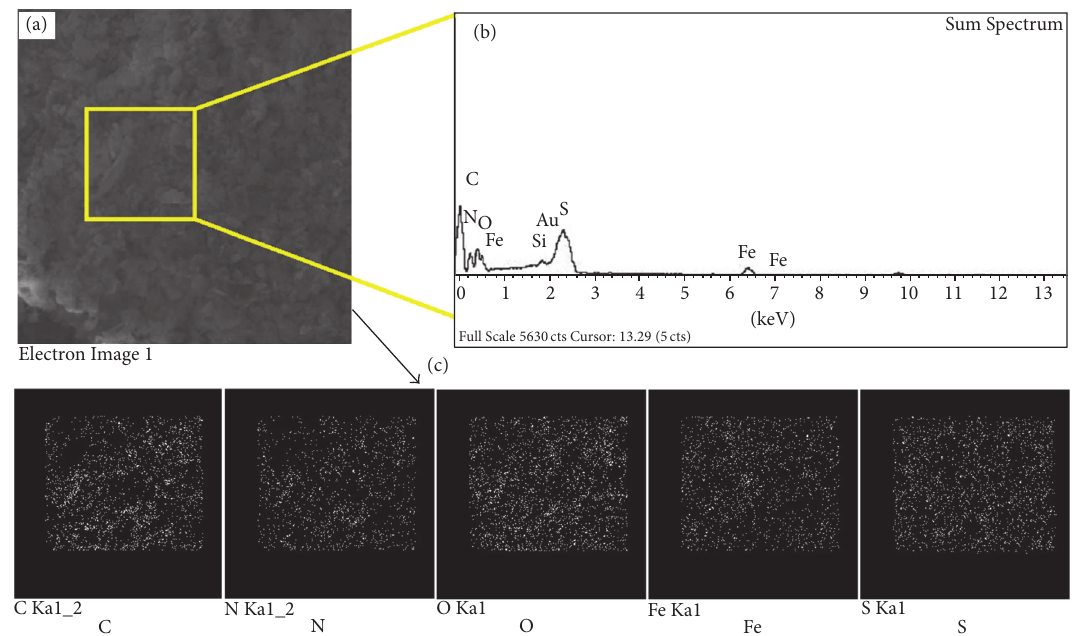
Figure 4: (a) Electron image for (b) EDX analysis and (c) element mapping analysis of PGMA-MAn/ABSAc@Fe 3 O 4 nanocomposite.